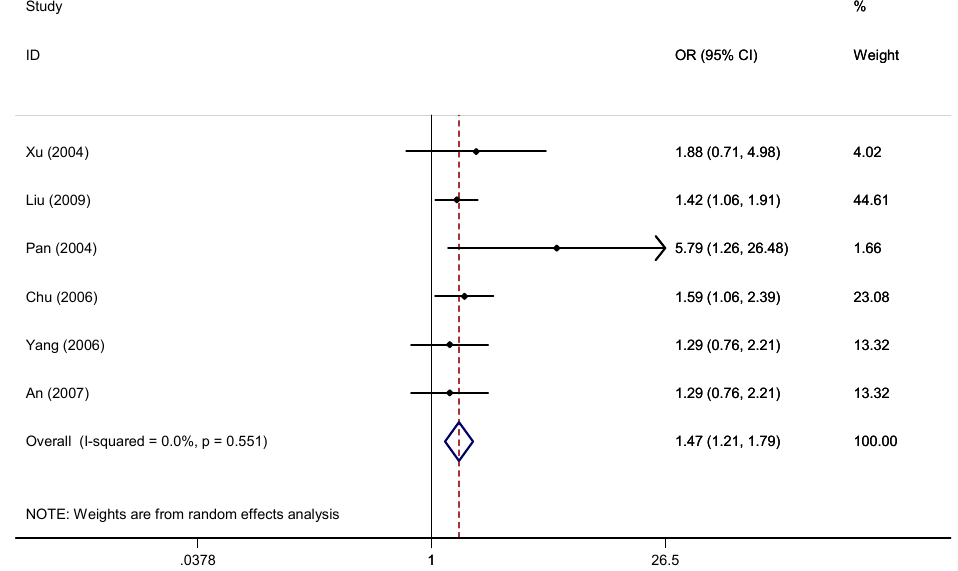
Figure 3. Forest plot for the meta-analysis of depression symptoms in children/adolescents with and without overweight/obesity.